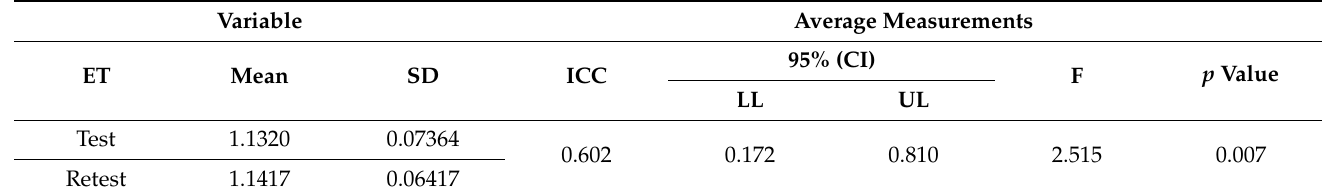
Table 3. Values in the ICC in the test–retest assessment of Execution Time (ET) and average